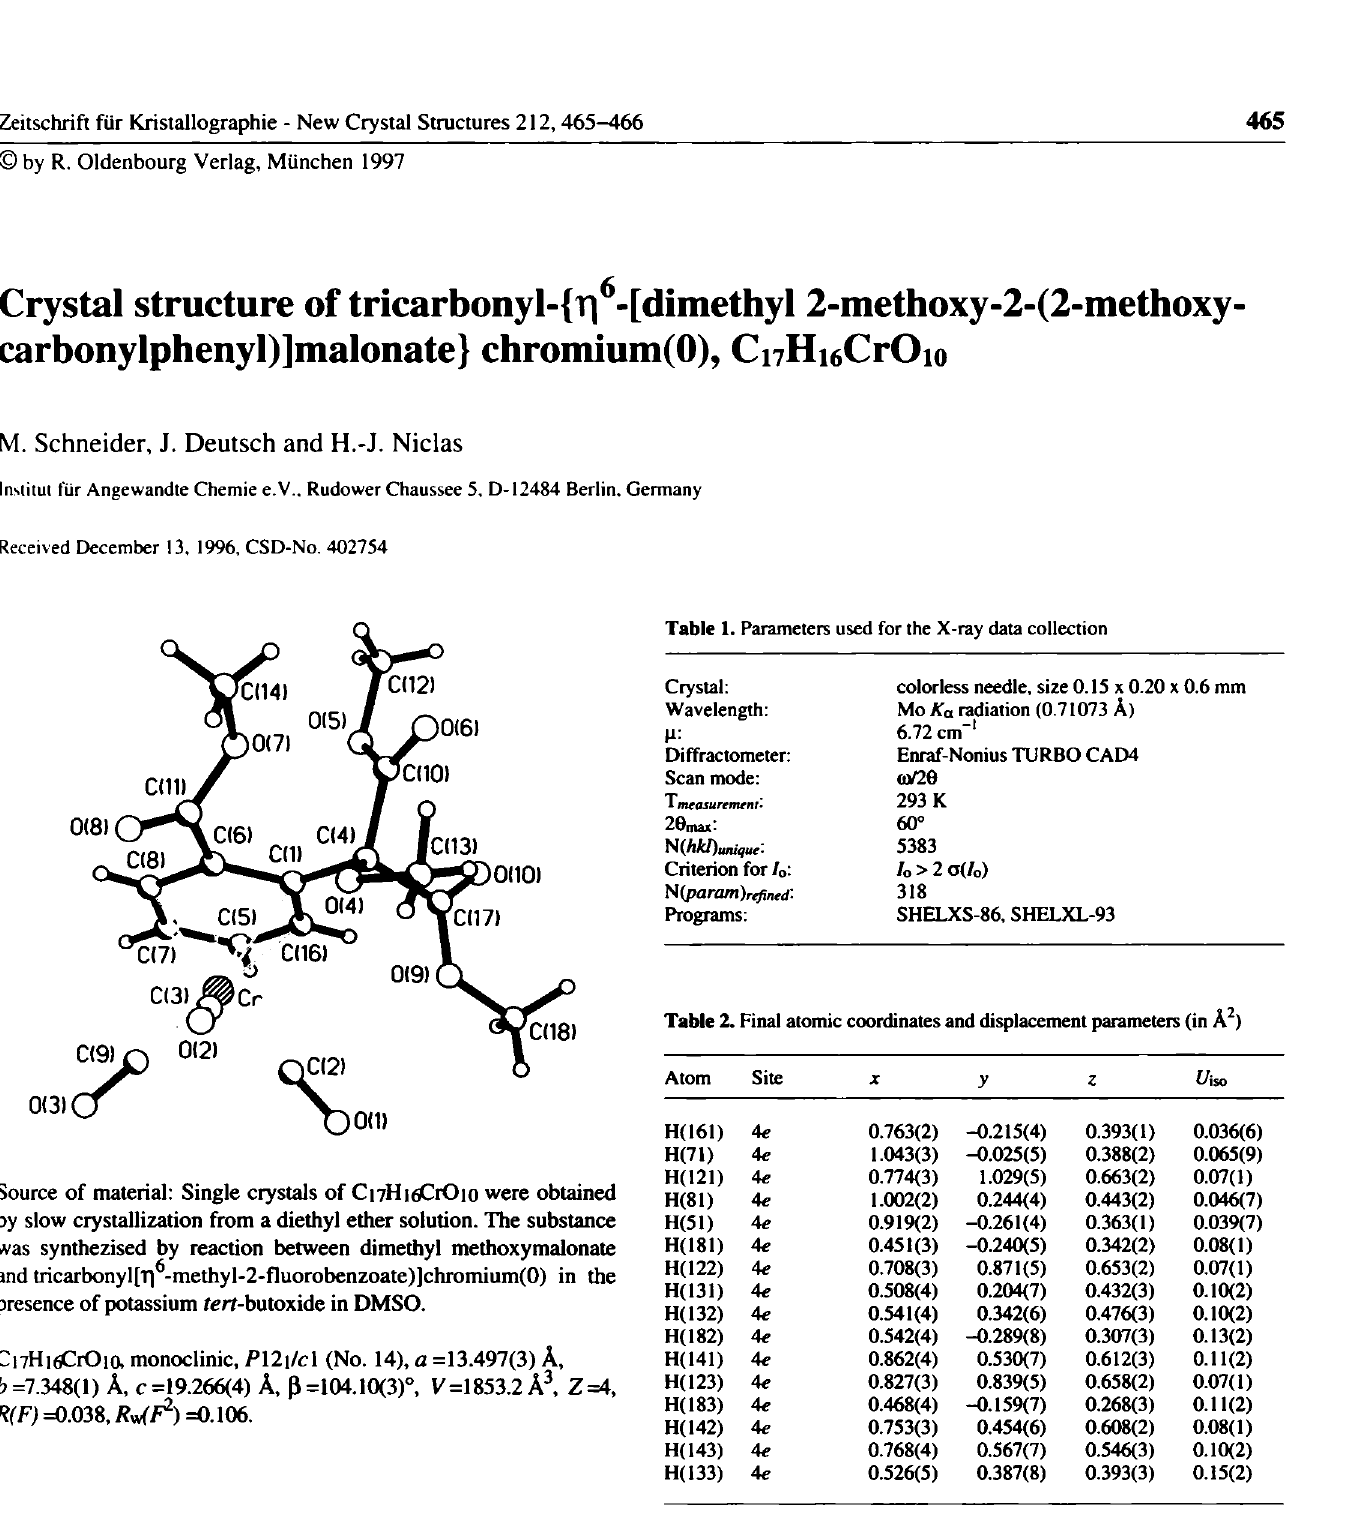
Table 3. Final atomic coordinates and displacement parameters (in Â 2